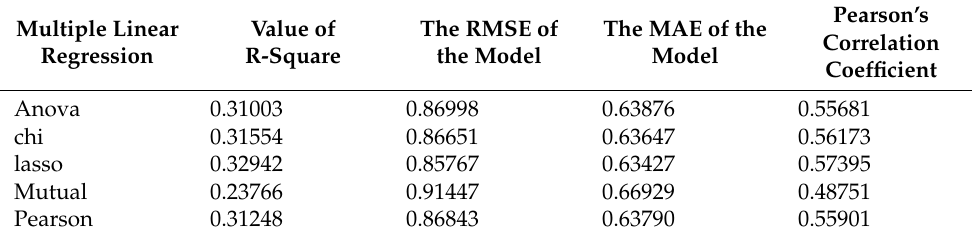
Table 5. Multiple Linear Regression.